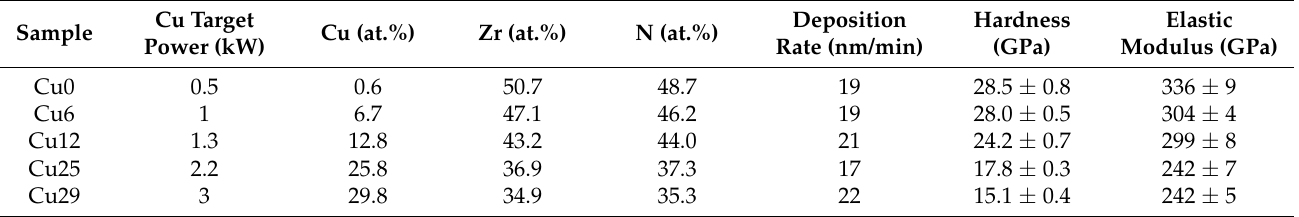
Table 1. Chemical composition, deposition rate, and the mechanical properties of the ZrN-Cu coatings with different Cu